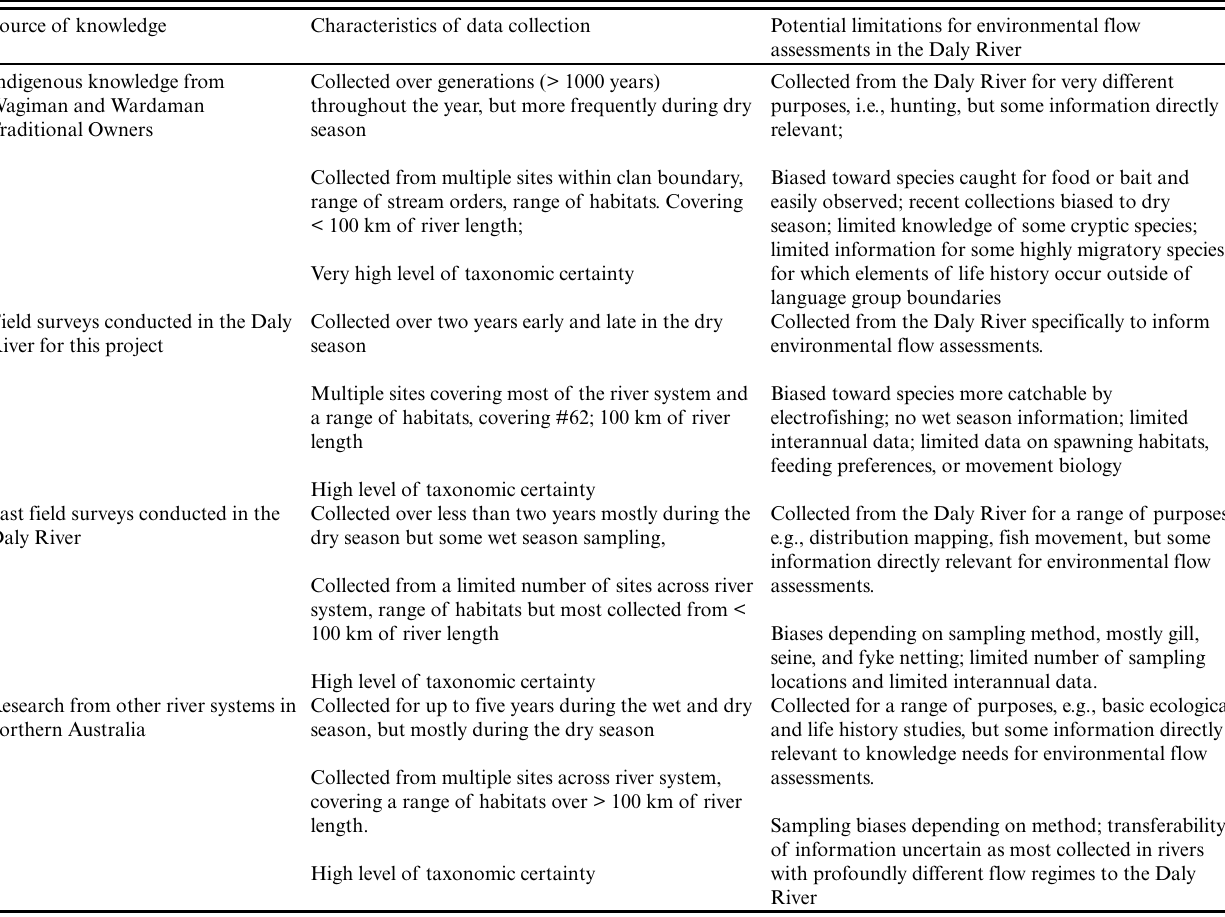
Table 2 . Characteristics of knowledge sources used in the project and an assessment of their suitability and potential limitations for environmental flow assessment of fish in the Daly